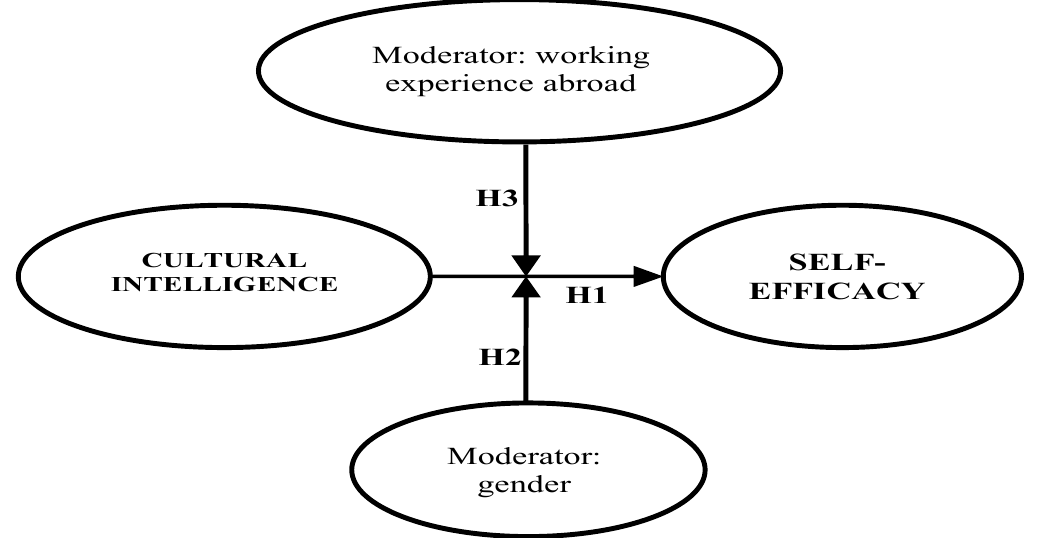
Figure 2. Conceptual model. Source: own creation.